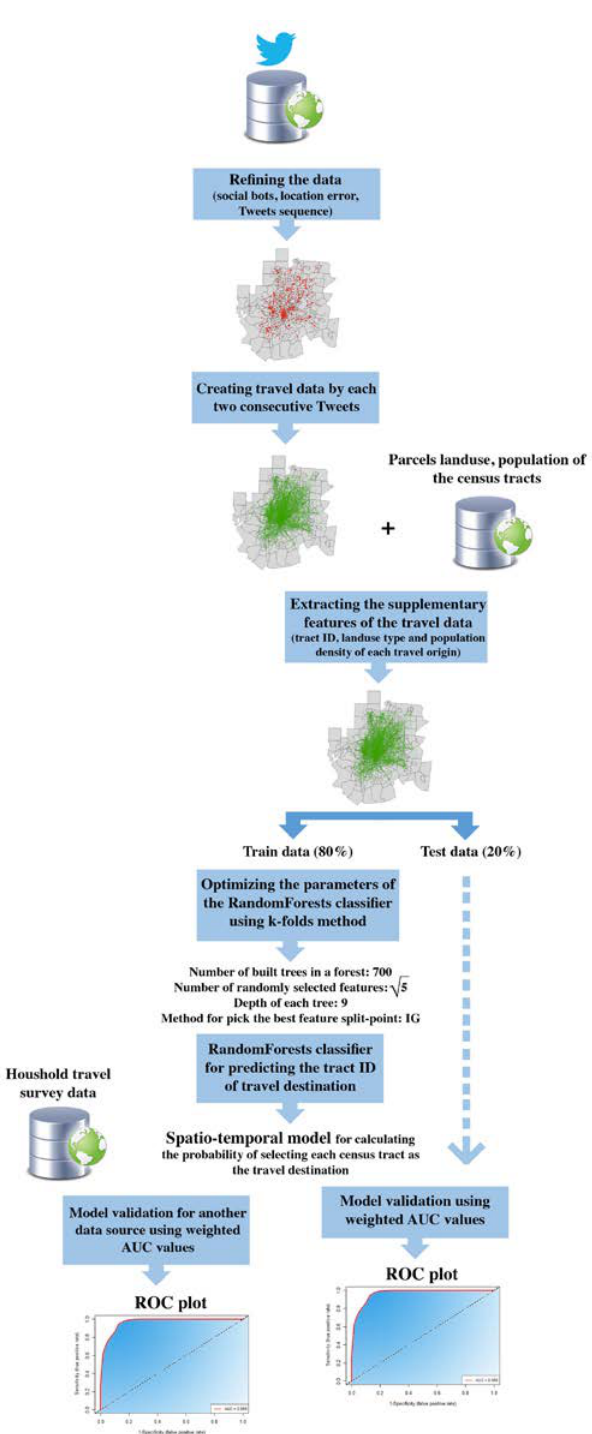
Figure 7. The flow chart of the modeling framework Using decision tree predictor, the probability of each class can be predicted, which is the fraction of training samples of the same class in a leaf. Probabilistic prediction results in RF are based on the mean predicted class probabilities of the decision trees in the forest. If d train is the dataset of training data with known class, c is the dataset of target classes, d test is the